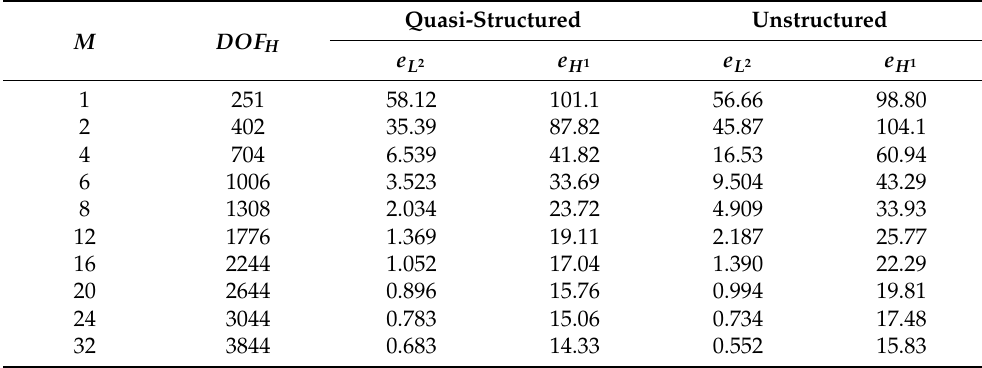
Table 5. Elliptic problem. Case 2 (non-homogeneous boundary conditions). Unstructured coarse grids. Relative L 2 and H 1 error in %. DOF h = 85,230.